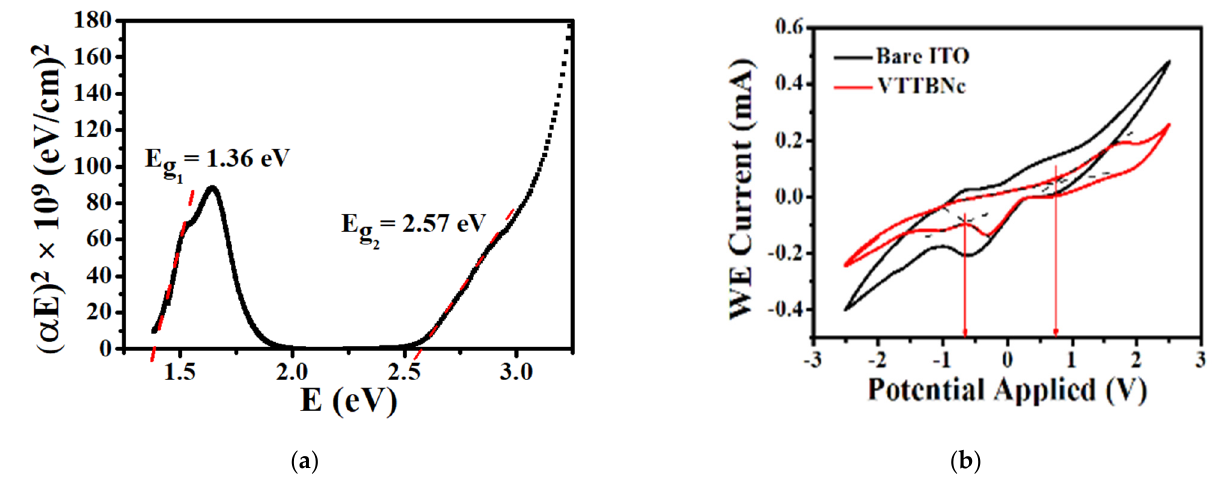
Figure 3. ( a ) Absorption spectrum Tauc plot of VTTBNc thin film. ( b ) Cyclic Voltammogram (CV) of measured current versus applied potential at a scan rate of 75 mV/s.